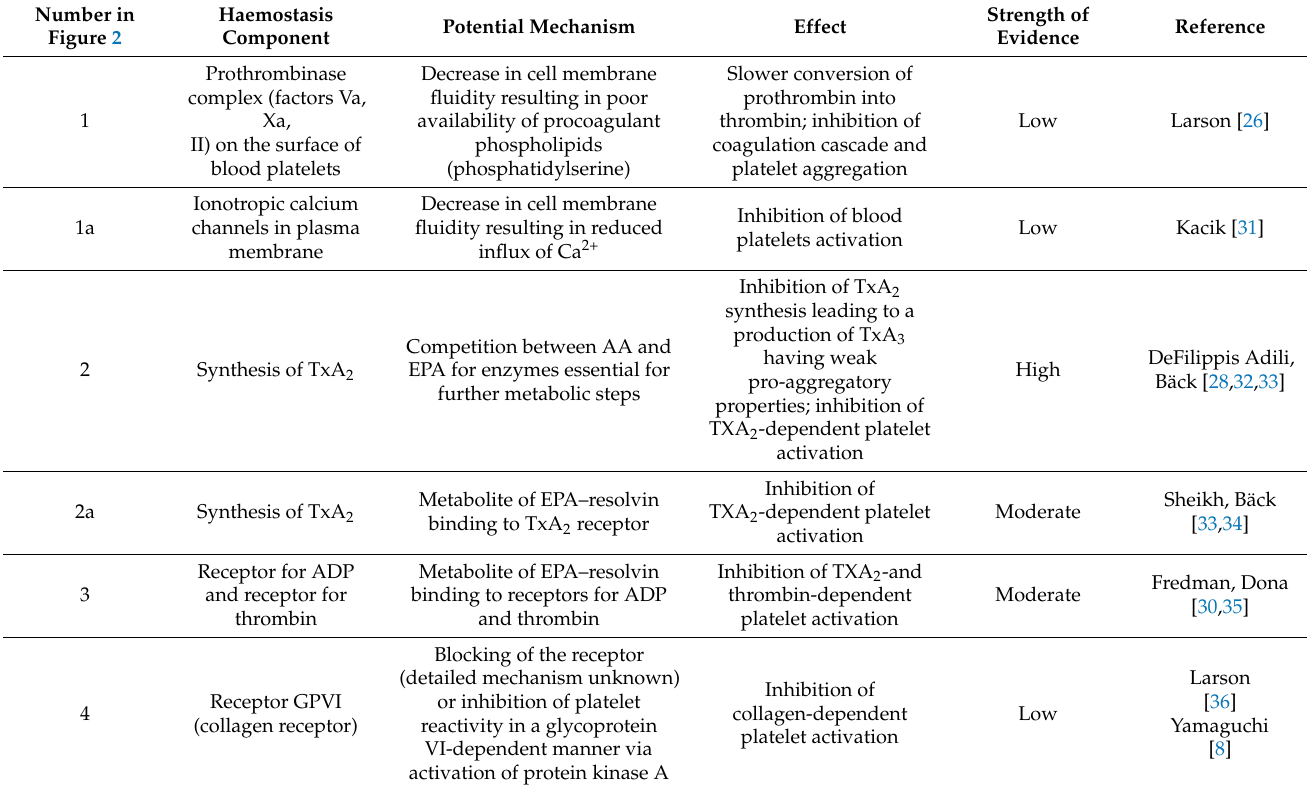
Table 1. Potential mechanisms of antiplatelet effects of EPA and DHA.